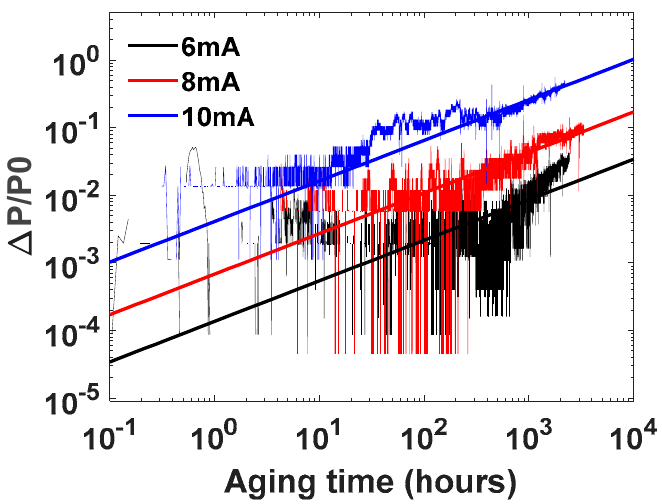
Figure 6. The rate of change in output power varies with the aging time at different electric stress. The mathematical relationships between output power degradation rates and aging time at 6 mA, 8 mA and 10 mA are fitted to Equations (5) to (7), respectively. According to Equations (5) to (7), the lifetime of devices at different currents can be calculated. Using the